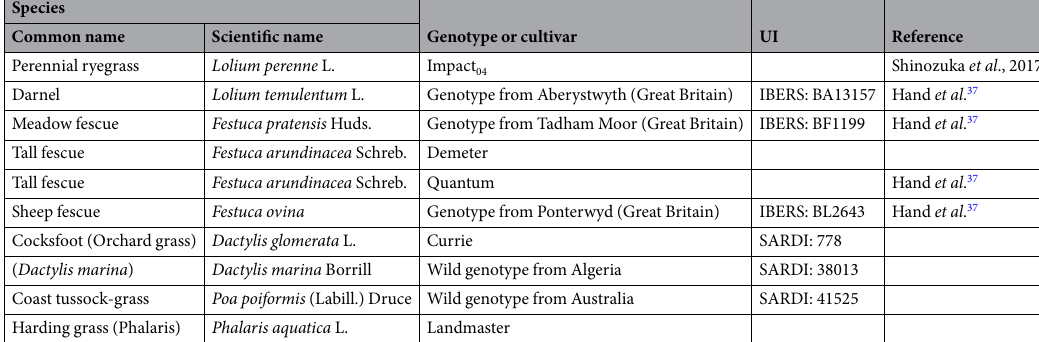
Table 1. Plant materials used in the current study. UI denotes the unique identifier of the Genetic Resources Unit of Institute for Biological, Environmental and Rural Studies (IBERS; Aberystwyth, Wales. UK) or the South Australian Research and Development Institute (SARDI).